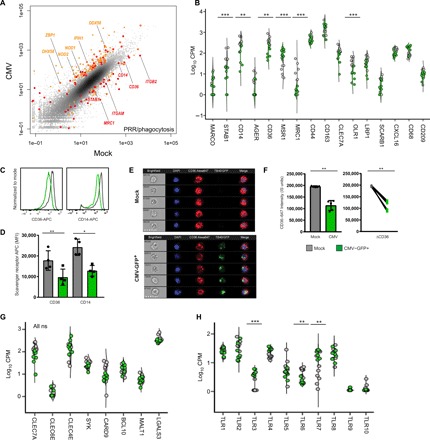
CMV infection of monocytes can concurrently induce the expression of cytoplasmic dsDNA viral PRRs and inhibit the surface expression of bacterial and fungal pathogen PRRs.(A) Scatter plot showing all transcripts detected by RNA-Seq in mock- and CMV-infected CD14+/16− monocytes. Differentially expressed genes within curated lists related to viral PRRs (orange), nonviral PRRs (red), and phagocytosis (red) are highlighted. (B) Binary violin plots showing the mRNA expression of all scavenger receptors as determined by RNA-Seq and (C and D) protein expression of scavenger receptors CD14 and CD36 using conventional flow cytometry. Overlay histogram plots that demonstrate the MFI of allophycocyanin (APC), the marker for CD14 or CD36 expression in mock- and CMV-infected monocytes from one representative experiment, is shown. Whisker plots include all composite data from biological replicates (n = 4, geometric MFI ± SEM, CD14 P < 0.0024, CD36 P < 0.001, paired t test). (E and F) Protein expression of surface CD36 was confirmed using ImageStream (Amnis) with panels displaying five representative mock- and CMV-infected monocytes. Magnification, ×40. Scale bars, 10 μm. Whisker plots include composite data from all biological replicates (n = 5 cells, ImageStream units; P < 0.0001, unpaired t test). Binary violin plots showing the mRNA expression of (G) select C-type lectin (CLEC) receptors and (H) TLRs in mock- and CMV-infected CD14+/16− monocytes. P values (C, D, and F) or FDR-adjusted P values (B, G, and H) are denoted as *P < 0.05, **P < 0.01, and ***P < 0.001. PRR, pattern recognition receptor; ns, not significant.